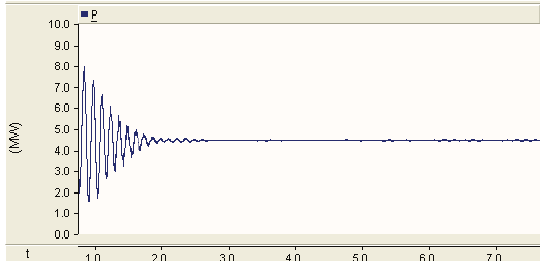
Table 5. Active power and reactive power